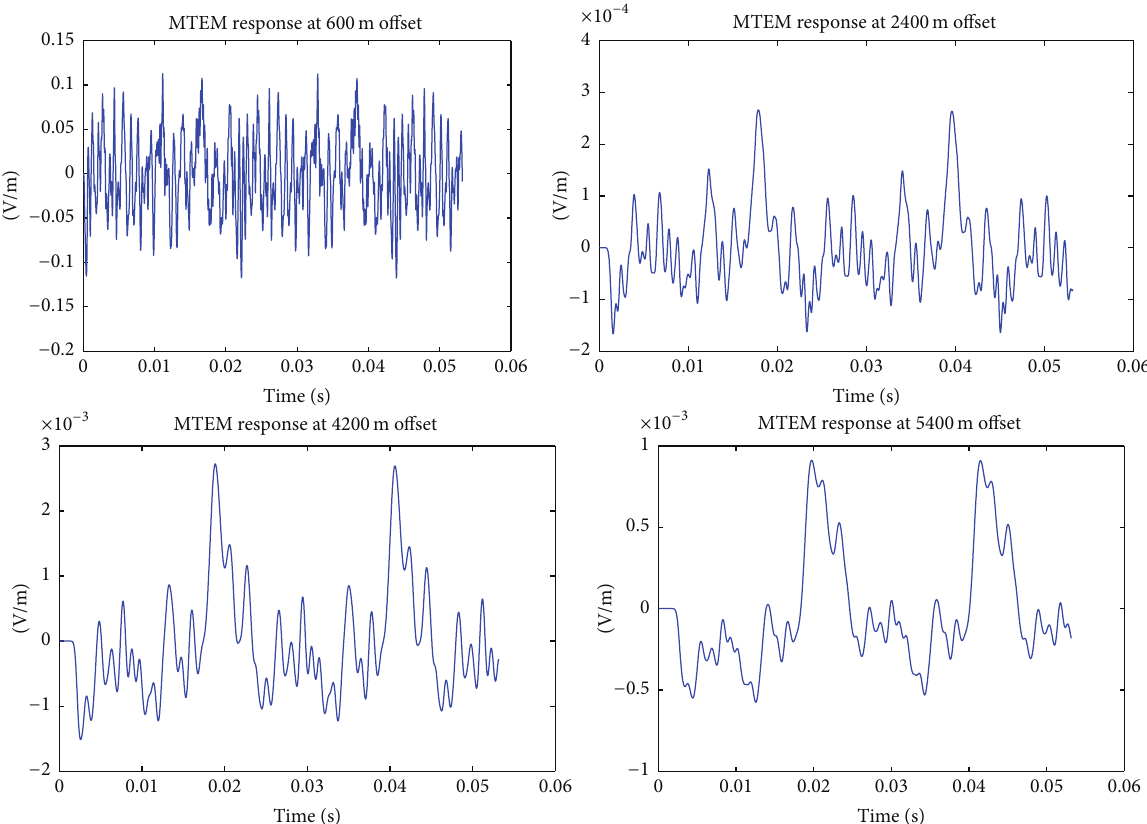
Figure 13: Unprocessed earth response plot against time at offsets 600 m, 2400 m, 4200 m, and 5400 m with Tx at 4200 m. The apparent resistivity values were calculated from the peak time obtained from each trace [40]. The obtained impulse response over a range of offsets at Tx 3000 m and 9000 m is shown in Figure 14.